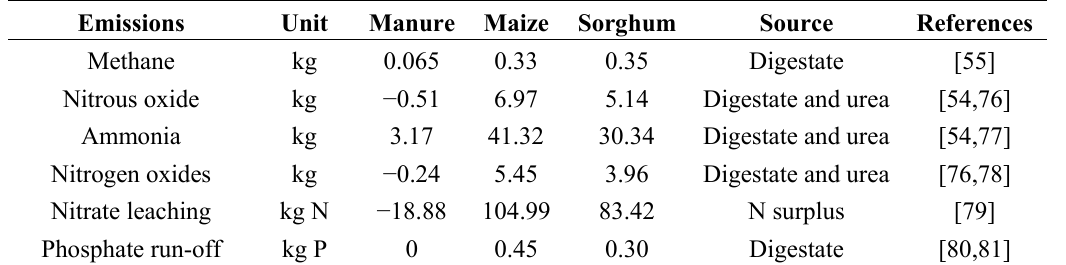
Phosphate run-off